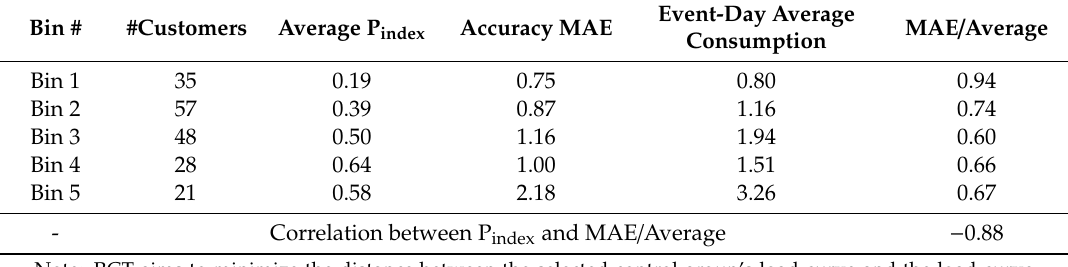
Table 4. The accuracy results of the Randomized Control Trial (RCT) CBL calculation